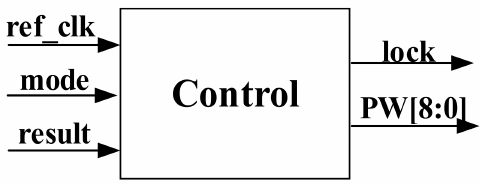
Figure 5. Block diagram of the Control